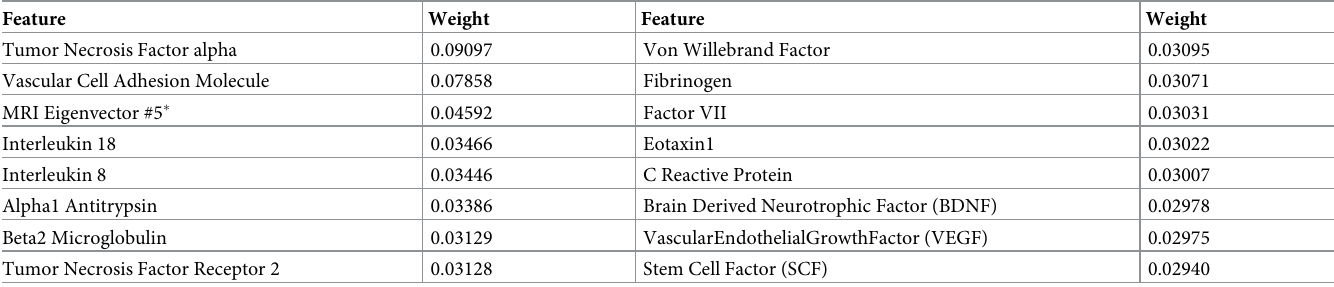
Table 4. GINI importance features from MRI PCA and kit